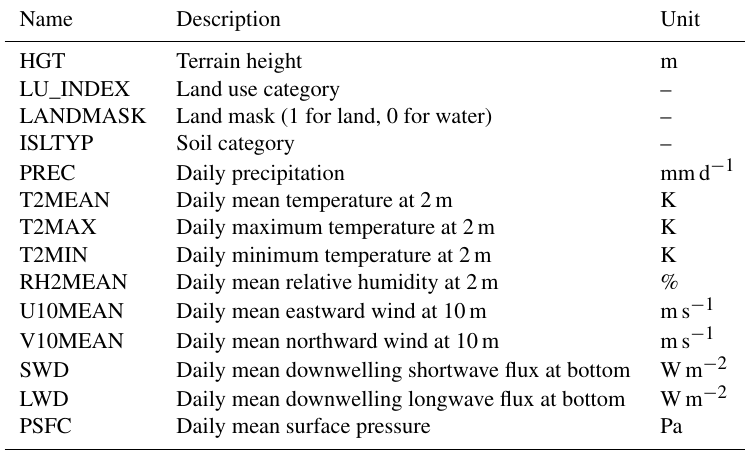
Table 1. Geostatic variables and meteorological elements in the HCPD-CA dataset.